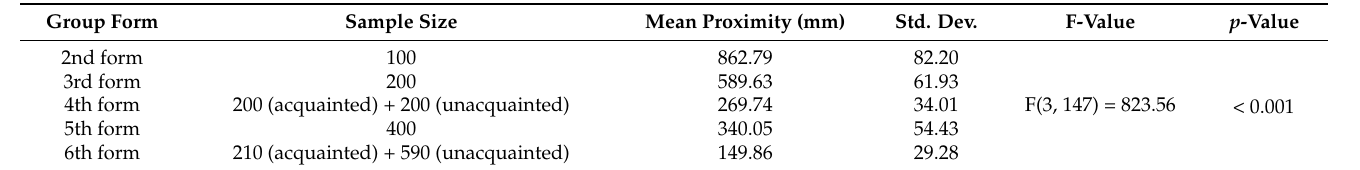
Table 3. A statistical result of the interpersonal proximity in group forms 2 to 6.